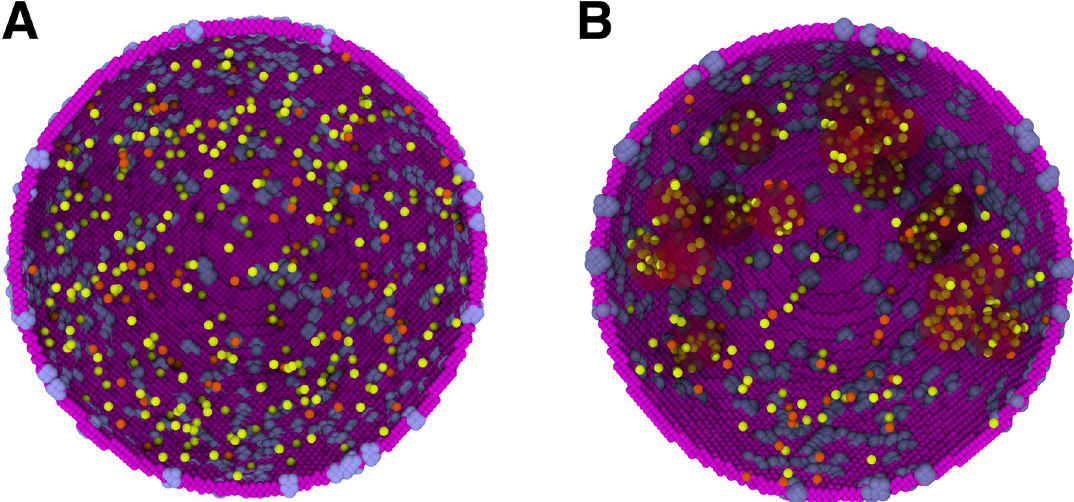
Fig 7. Formation of speckles in our simulations: A) splicing particles (U1 and U2 colored in yellow and orange, respectively) diffusing freely in the nucleus without speckle, B) Introduction of an imbalance on transition probabilities of splicing particles from the nucleus to speckles results in the localization of the splicing particles in the speckles shown as red-shaded regions.